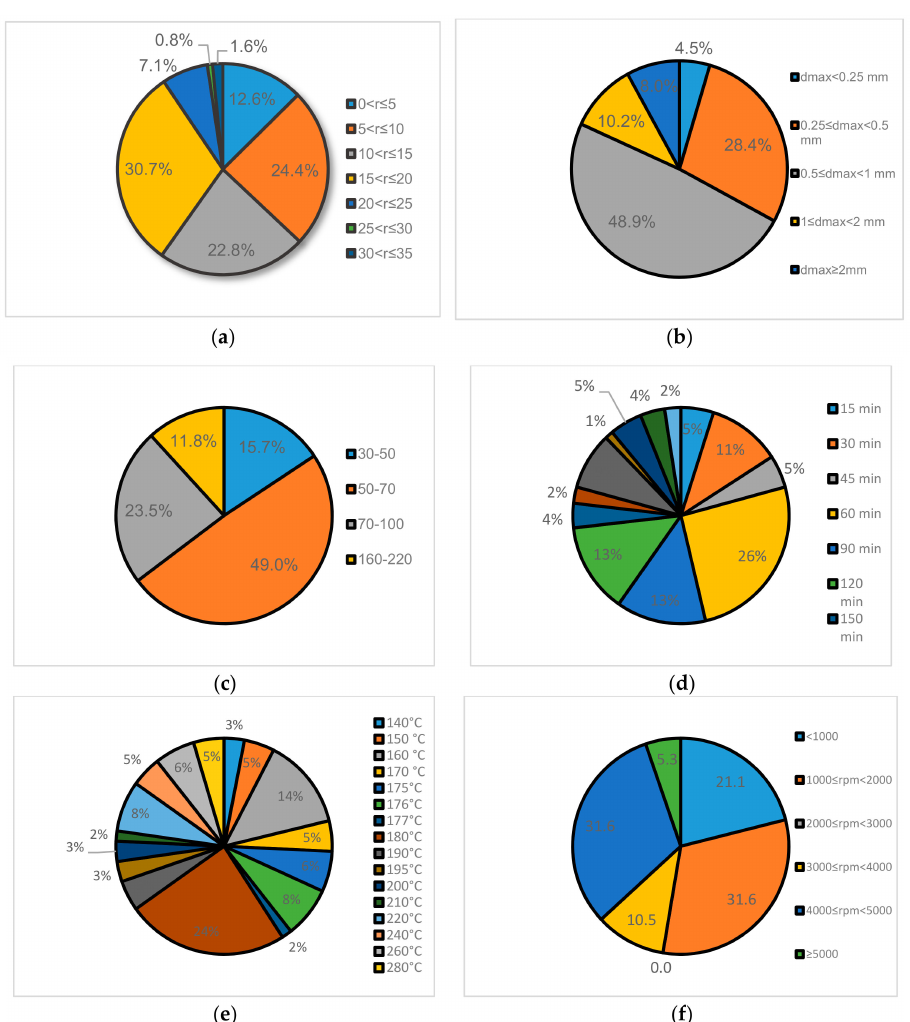
Figure 5. Most common types and percentages of ( a ) rubber content, ( b ) maximum size, ( c ) base bitumen penetration, ( d ) mixing time, ( e ) temperature, and ( f ) shear